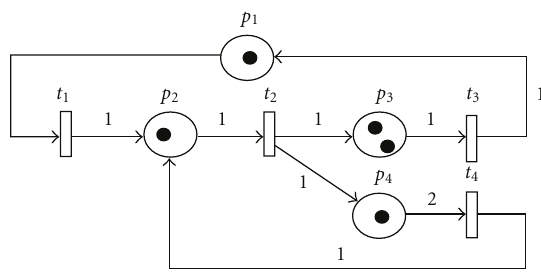
Figure 4: Primary user’s behavior.